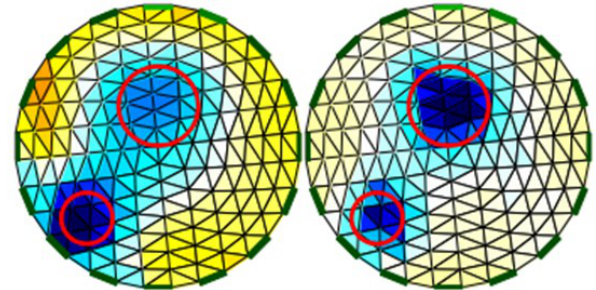
Fig. 5: Comparison of the phantom reconstruction obtained with the linear inverse solver (left), and the proposed method using ANN and PSO (right). Both targets are indicated by red circles